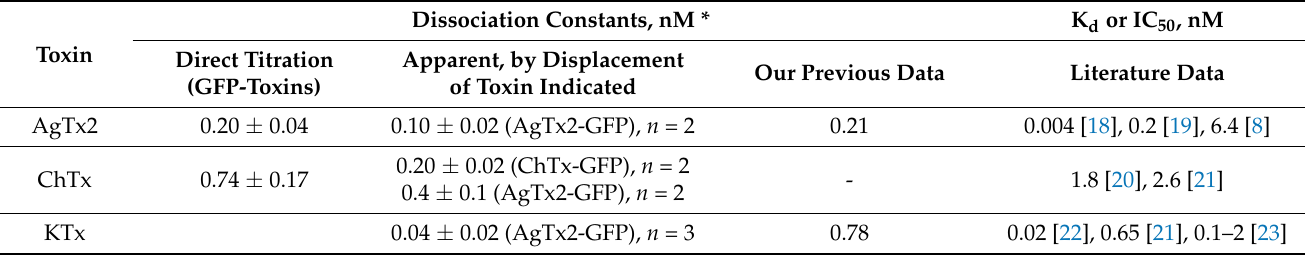
Table 1. K d values obtained by direct titration of GFP-toxins or by their displacement with unlabeled ones and their comparison to our previous and literature